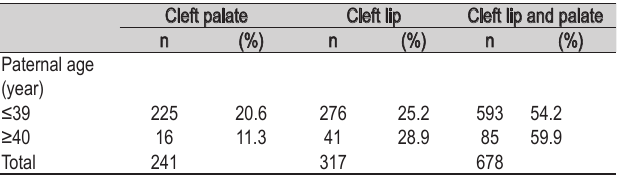
Table 3 - Distribution of non-syndromic cleft lip and/or palate according to type and paternal age.